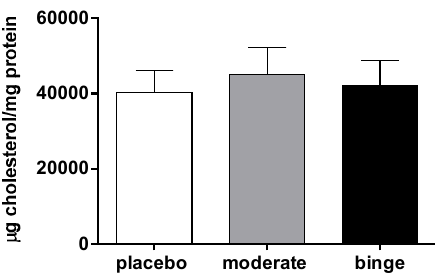
Figure 2. Hepatic cholesterol content in mice undergoing moderate and binge alcohol consumption. Apo E -/- (B6.129P2-apoE tm1Unc/Crl ) mice were treated with alcohol for 28 days as described in the Methods Section. On day 28 of treatment, mice were sacrificed and the livers were collected after perfusion with a saline solution. Cholesterol was extracted according to Bligh and Dyer method, and successively quantified using a fluorimetric assay as described in the Methods Section. Data are presented as μ g of cholesterol per mg of tissue proteins (mean ± SEM; n = 9–10 mice per group). Results were analyzed using one-way ANOVA followed by Tukey’s multiple comparison test among groups.